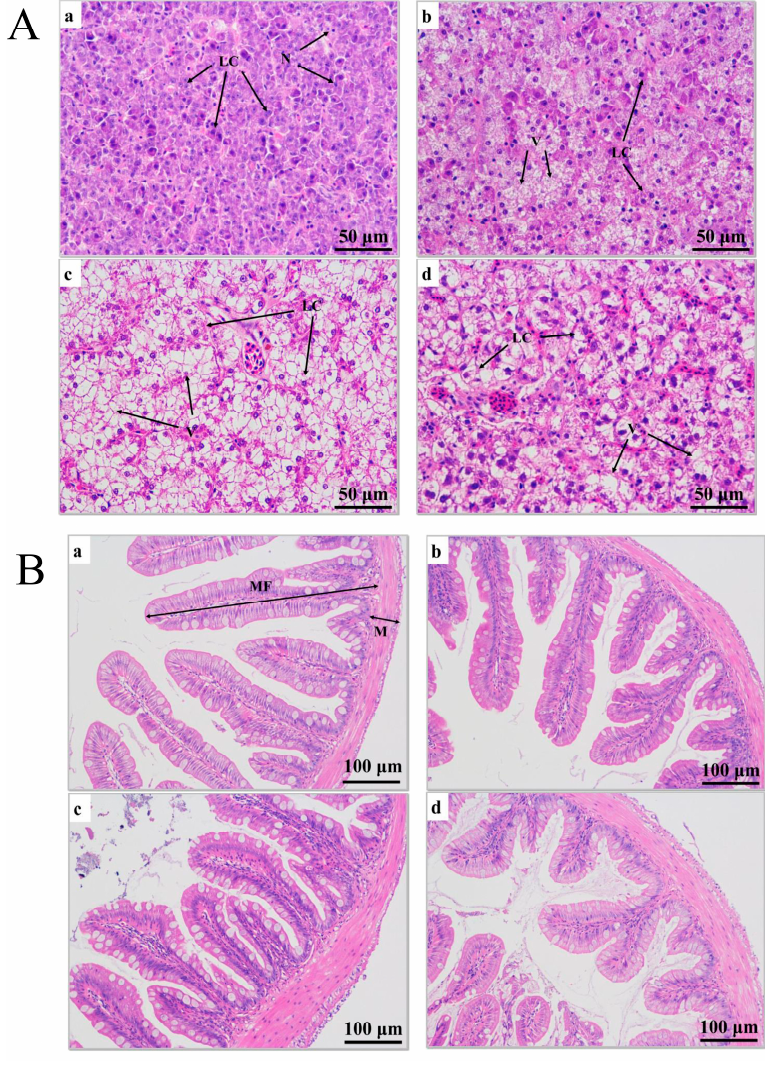
Figure 2. ( A ) Histopathological sections of juvenile largemouth bass livers under transport stress. LC: liver cells; N: nucleus; V: vacuoles. Scale 1:400. ( B ) Histopathological sections of juvenile largemouth bass intestines under transport stress. MF: intestinal villi; M: muscular layer. Scale 1:200. Sections under transport stress at 0 h ( a ), 6 h ( b ), 12 h ( c ) and after 5 d of recovery ( d ) after transpor ‐ tation. Table 1. Changes in liver vacuolar area, intestinal muscular thickness and villus length in juvenile largemouth bass under transport stress.